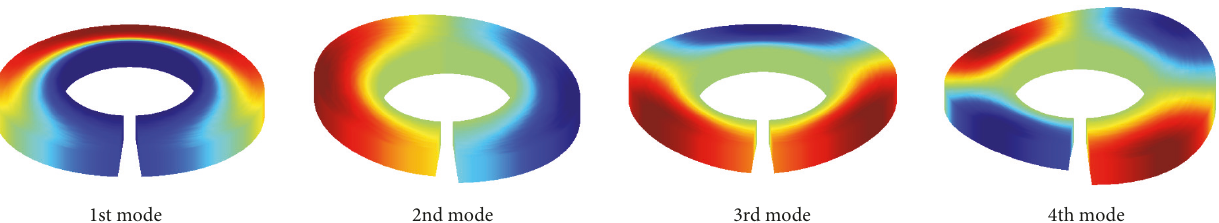
Figure 6: Mode shapes of the FG sandwich annular sector plate with CE 1 E 1 E 1 boundary condition and different sector